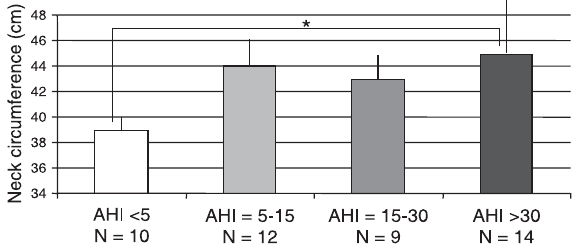
Figure 1. Neck circumference and severity of obstructive sleep apnea syndrome in class III obese patients. Data are reported as means ± SD for N subjects in each group. AHI = apnea-hypopnea index. *P = 0.02 (ANOVA).